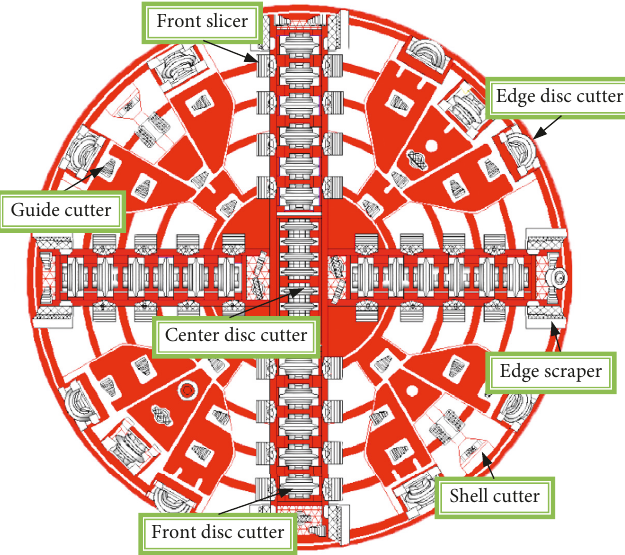
Figure 6: Layout of the shield cutter head and